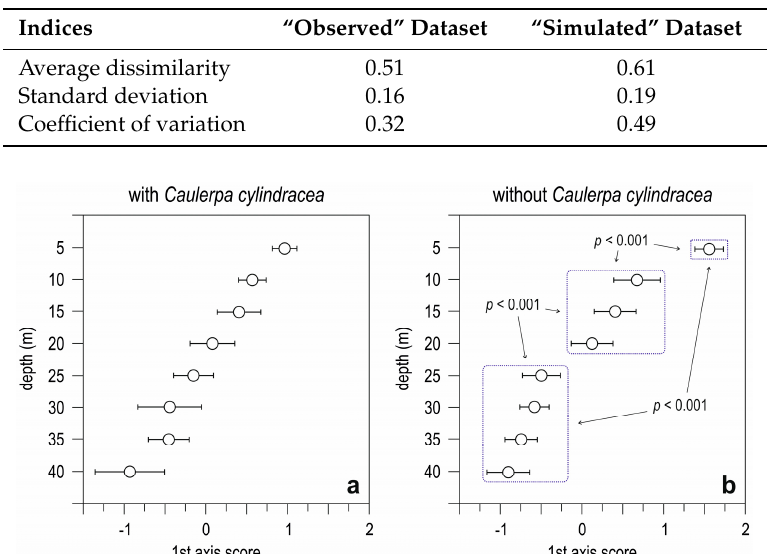
Table 5. Values of the average dissimilarity (1—Bray-Curtis coefficient), standard deviation, and coefficient of variation among samples in the “observed” and in the “simulated” datasets.